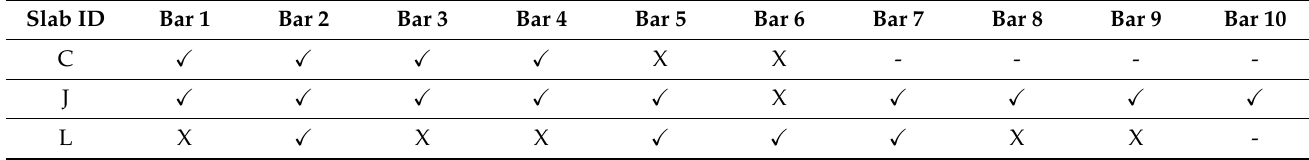
Table 5. Bar detectability in line scans performed using Conquest 100